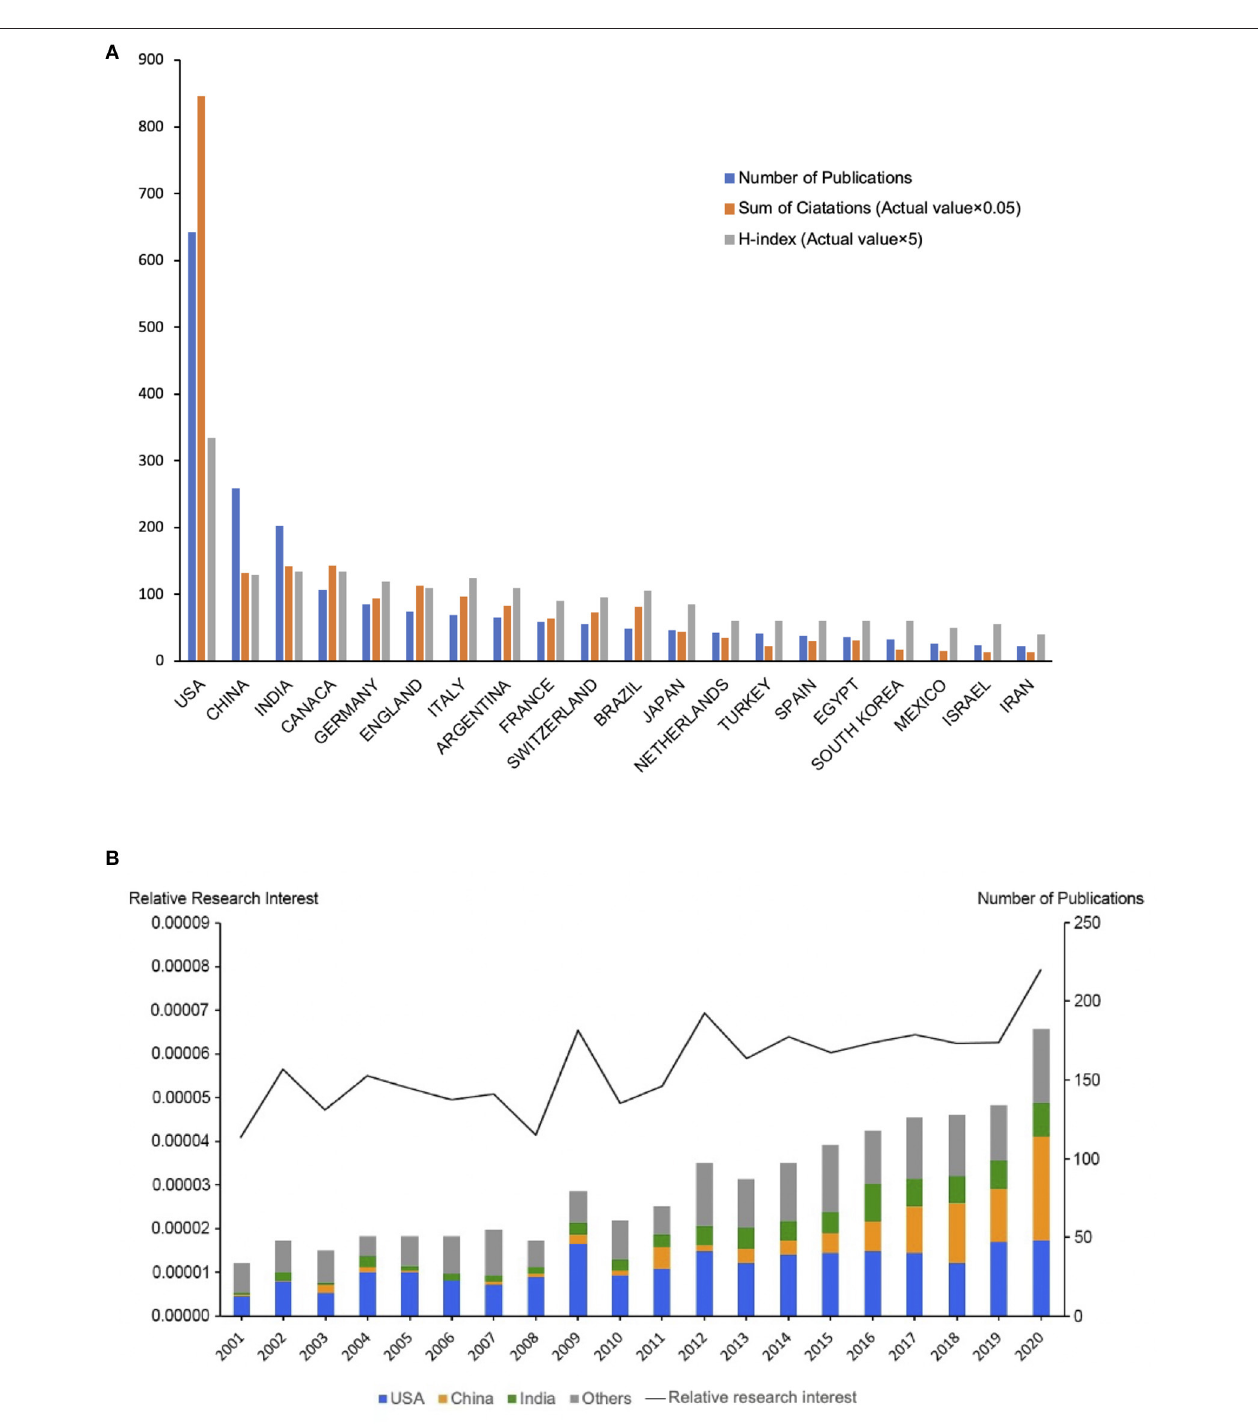
FIGURE 2 | Contributions of different countries/regions to retinoblastoma research. (A) The number of publications, sum of citations ( × 0.05), and H-index ( × 5) of the top 20 countries or regions; (B) The number of publications worldwide and the top 3 countries per year are shown in the histogram. The time course of relative research interest is shown in the line